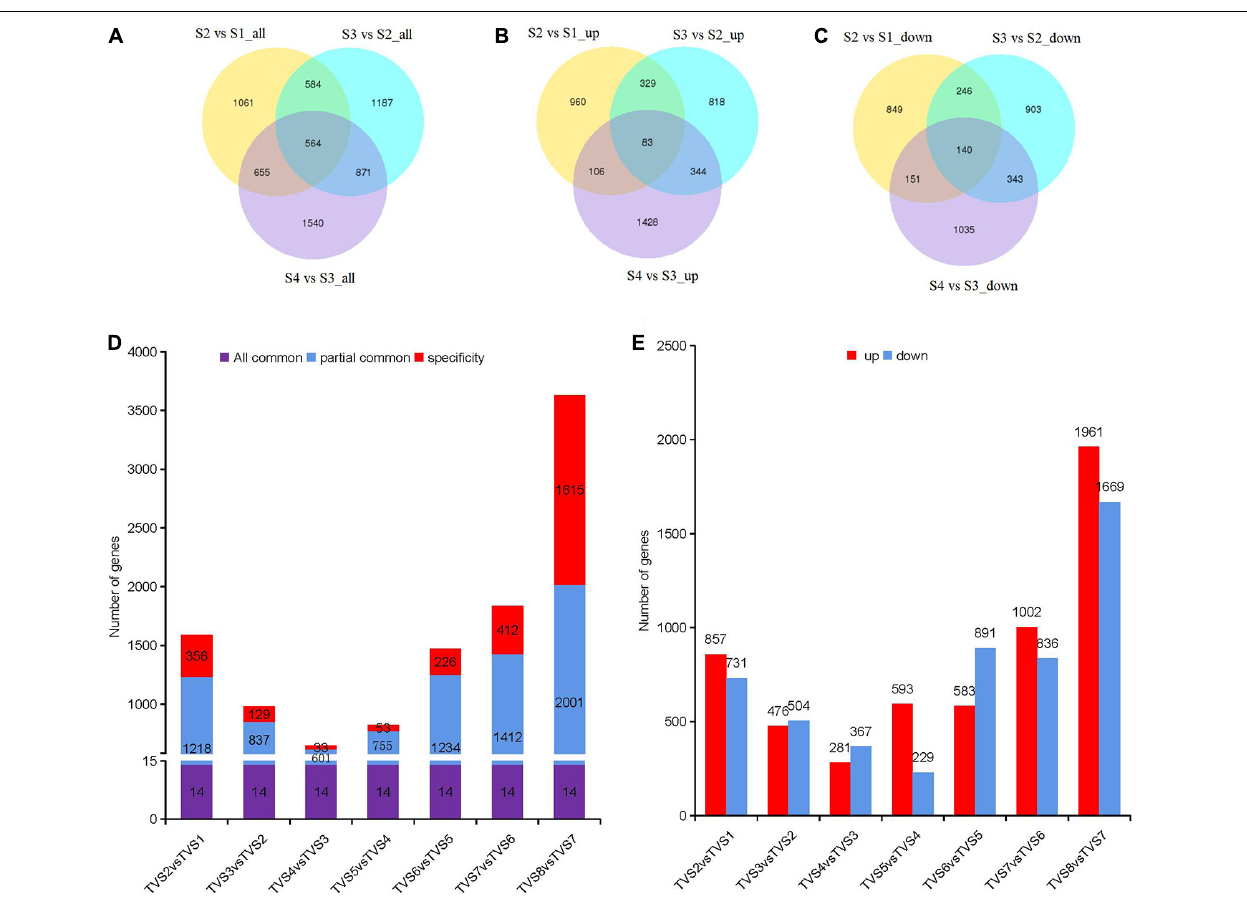
FIGURE 3 | DEGs analysis among samples of adjacent stages and time points. Diagrams comparing shared and specific DEGs between adjacent developmental stages and sampling time points of CF. Venn diagrams of S2 vs S1, S3 vs S2 and S4 vs S3. (A) All DEGs. (B) Up-regulated DEGs. (C) Down-regulated DEGs. The non-overlapping regions represent DEGs unique to each comparison; Overlapping regions represent DEGs shared by two or more combinations. The number in the circle represents the number of DEGs. (D) Diagrams comparing shared and specific DEGs among samples of adjacent time points. The number of DEGs are indicated in the center of histograms. “All common” represents the DEGs that were shared by all comparisons. “Partially common” refers to DEGs that were shared by two or more comparisons. “Specific” refers to DEGs that were unique to a specific comparison. (E) Up-regulated and down-regulated DEG distribution between adjacent time points. The number of DEGs are indicated above the